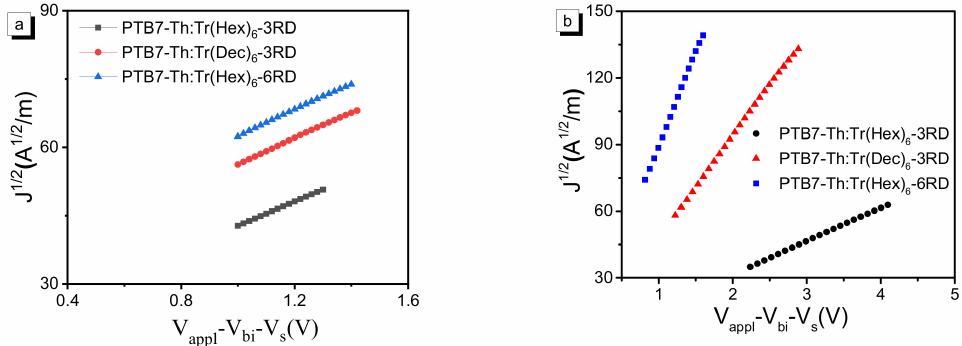
Figure 6. J 1/2 – V characteristics of PTB7-Th: truxene-centered acceptors blend films in electron-only devices ( a ) and hole-only devices ( b